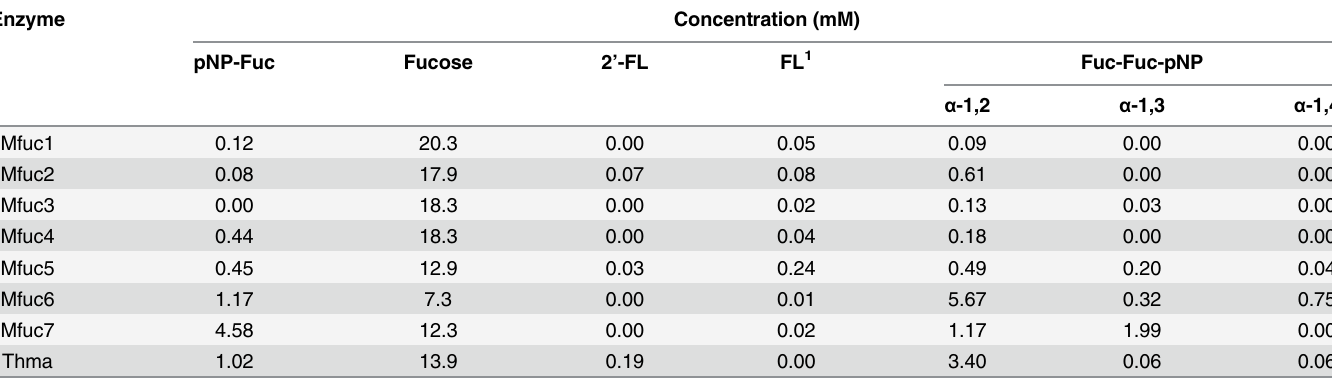
(Table 4). The product of Mfuc5 was analysed by both NMR and liquid chromatography-mass Table 4. Fucosylated products from trans-fucosylation reactions.